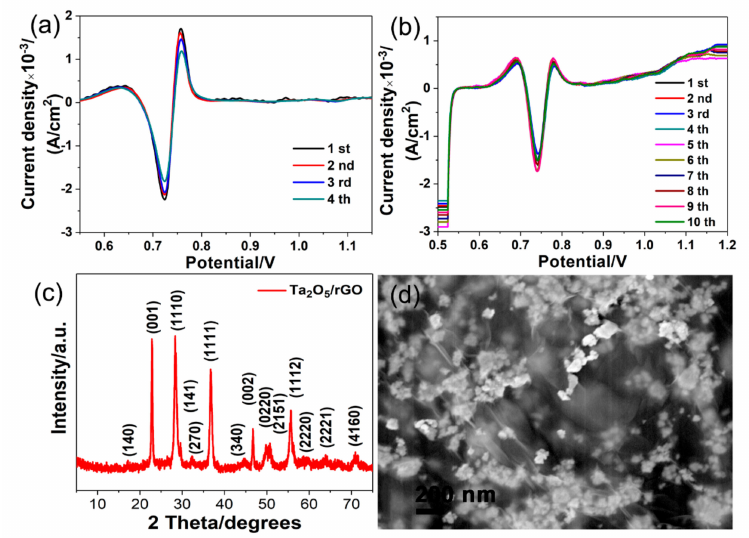
Figure 7. Second-order derivative linear scan voltammograms of tryptophan on four di ff erent Ta 2 O 5 -rGO-GCEs ( a ), on one Ta 2 O 5 -rGO-GCE repeated for 10 times ( b ); the XRD pattern ( c ) and the SEM image ( d ) of Ta 2 O 5 -rGO-GCE after ten-times repeated detection of tryptophan.